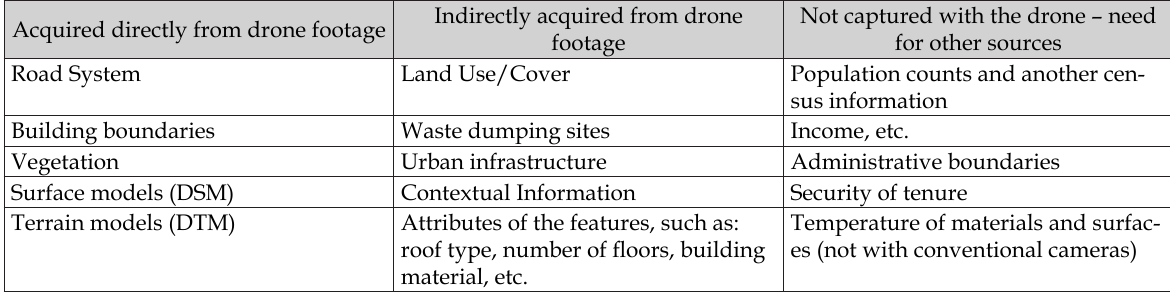
Table 1. Examples of geo-data possible to get with UAVs (drones). Adapted from Gevaert et al. 2018. Indirectly acquired from Acquired directly from drone footage